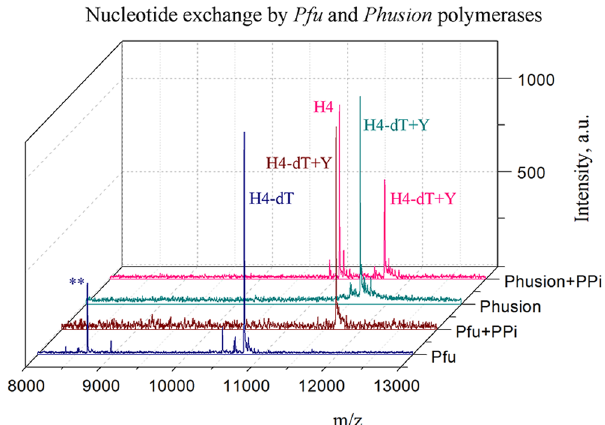
Figure 7. MS analysis of the hairpin modification (H4) by the Phusion and Pfu polymerases at 64 °C for 2 hours in the presence of 200 μ M nucleotide Y. Pfu polymerase can excise the terminal dT in the absence of PPi. Partially degraded hairpin Cy3-AGGGAGTTGGTCTGATT-TTCAGACC ( ** ) was also detected in the spectrum. Nucleotide exchange was only observed in the presence of 0.4 mM PPi. Phusion polymerase can generate the H4-dT + Y product without PPi because of exonuclease and polymerase